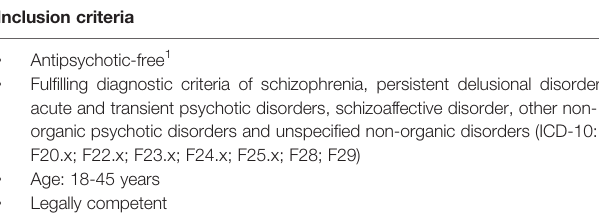
TABLE 1 | In- and Exclusion Criteria in Sub-Sero. Inclusion